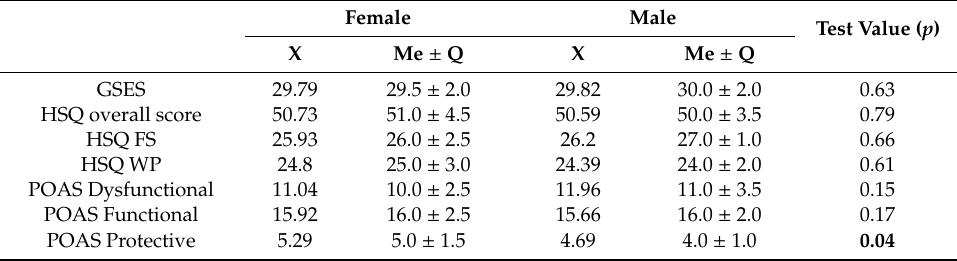
Table 2. Di ff erences between male and female participants after the intervention (n = 276). Female